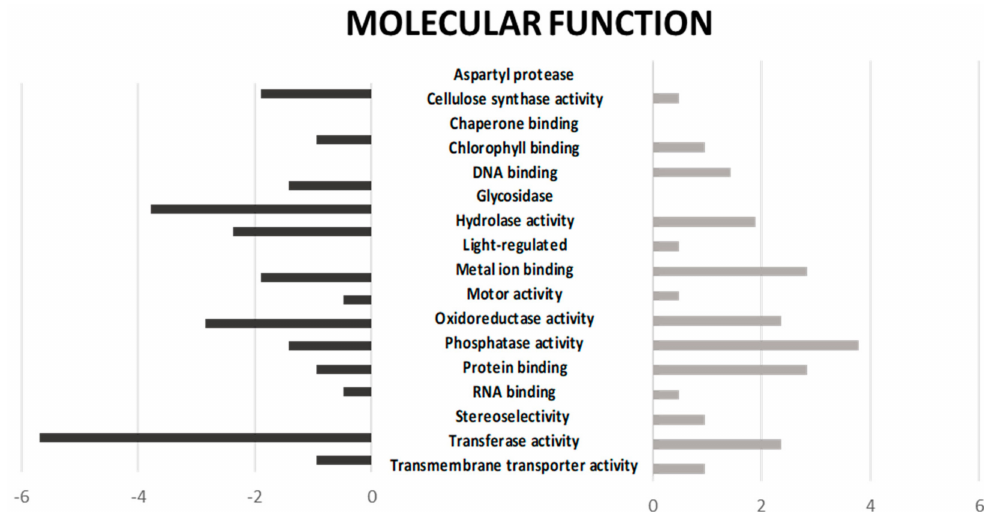
Figure 2. Molecular function depicted as a percentage of induced (grey bars) and repressed (black) di ff erentially expressed genes.